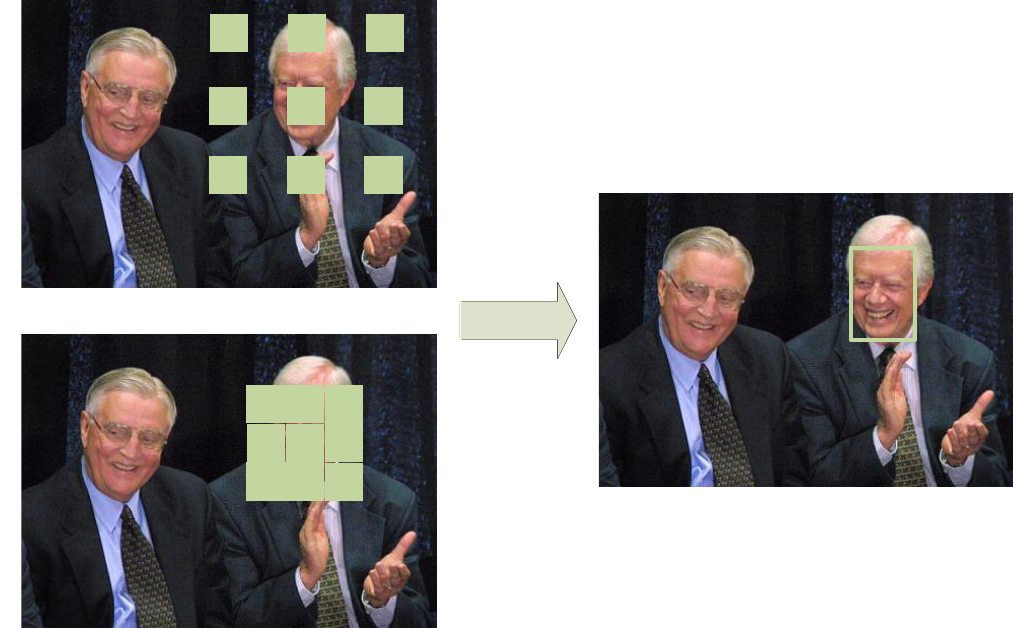
The illustration of using the head–shoulder region as the context information for face